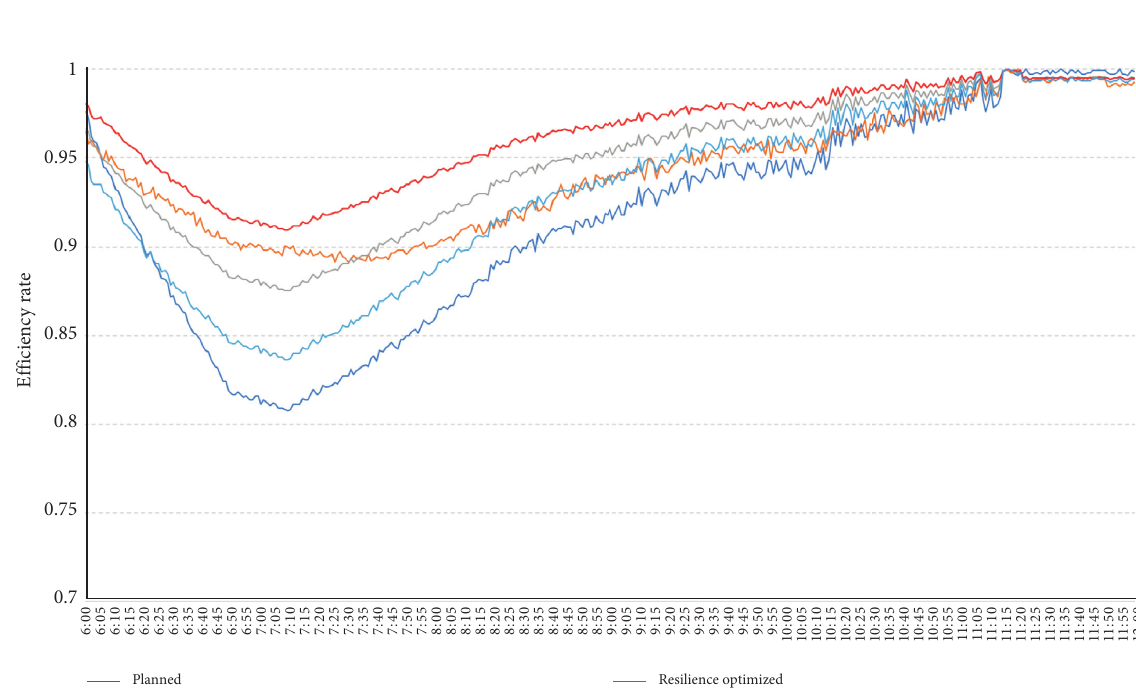
Figure 4: Detailed comparison of these optimization